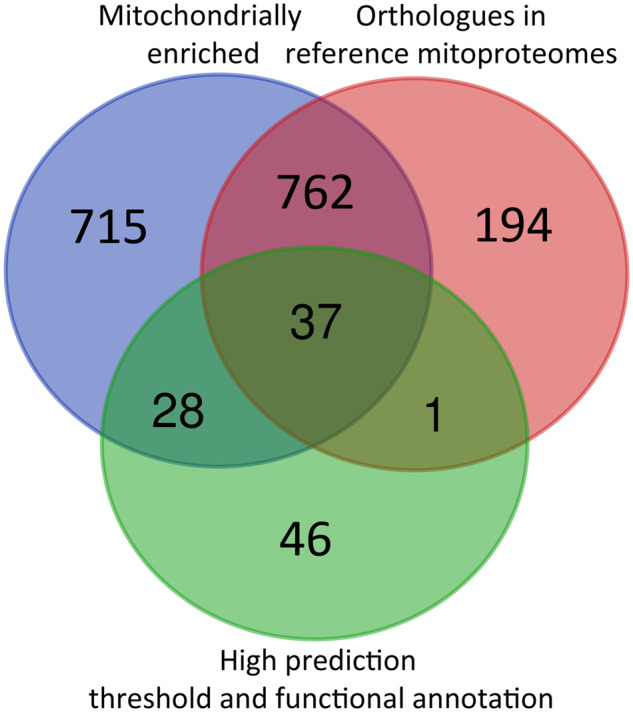
Diagram of identifying strategies used for majority ID transcripts of Euglena gracilis mitoproteome. List of proteins grouped by identification strategy is available in supplementary table 4, Supplementary Material online.